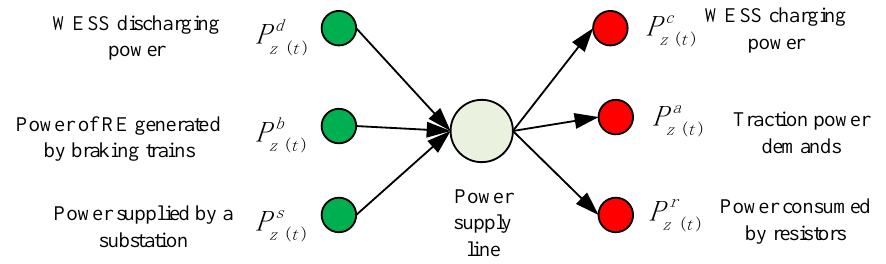
Figure 4. Energy suppliers and consumers in an electricity supply